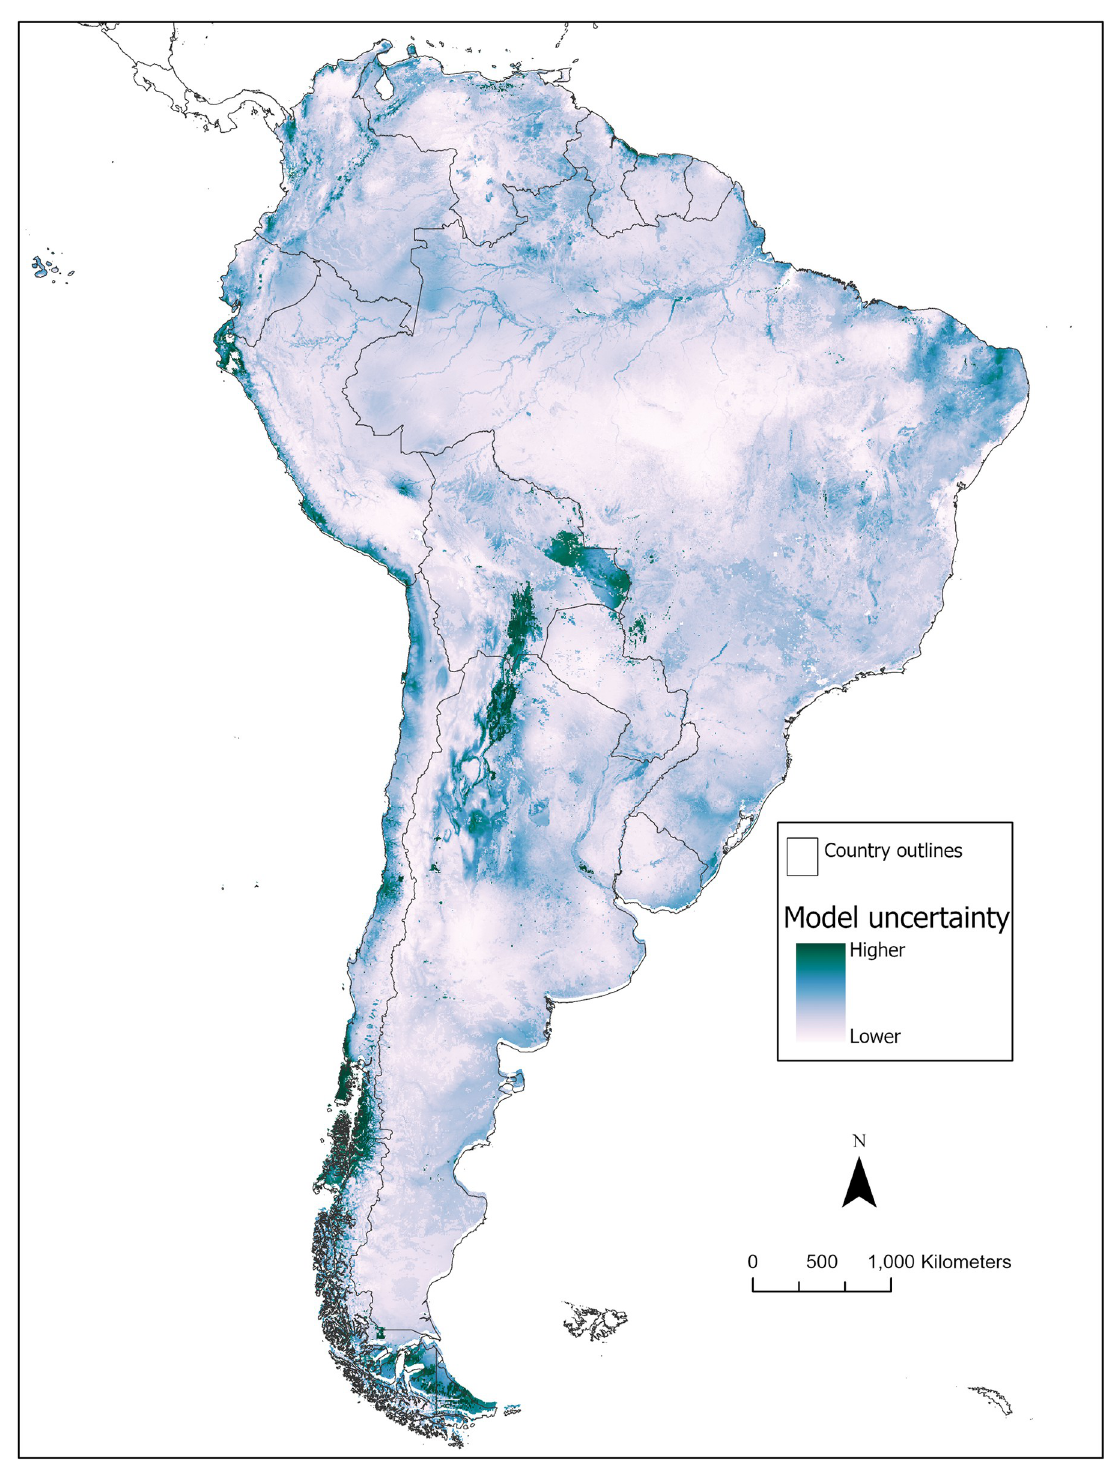
Fig 3. Map of model uncertainty. Estimated uncertainty in spatial prediction of Hg . janthinomys habitat suitability based on standard deviation for each pixel across the 20 model replicates. Base map sourced from Global Administrative Areas (GADM) version 4.0: https://